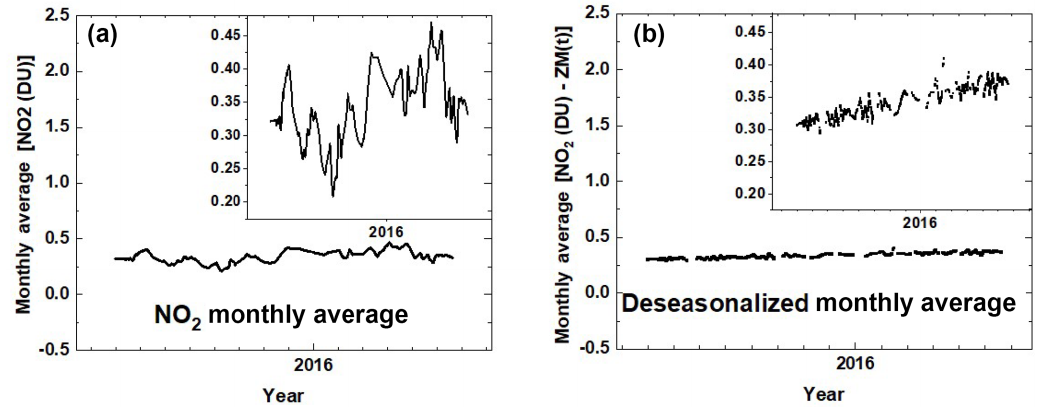
Figure A1. An illustration of the deseasonalization (b) of the monthly running average of NO 2 for the Gwangju site (a) shown in Fig. 6. The insets are magnifications of the main